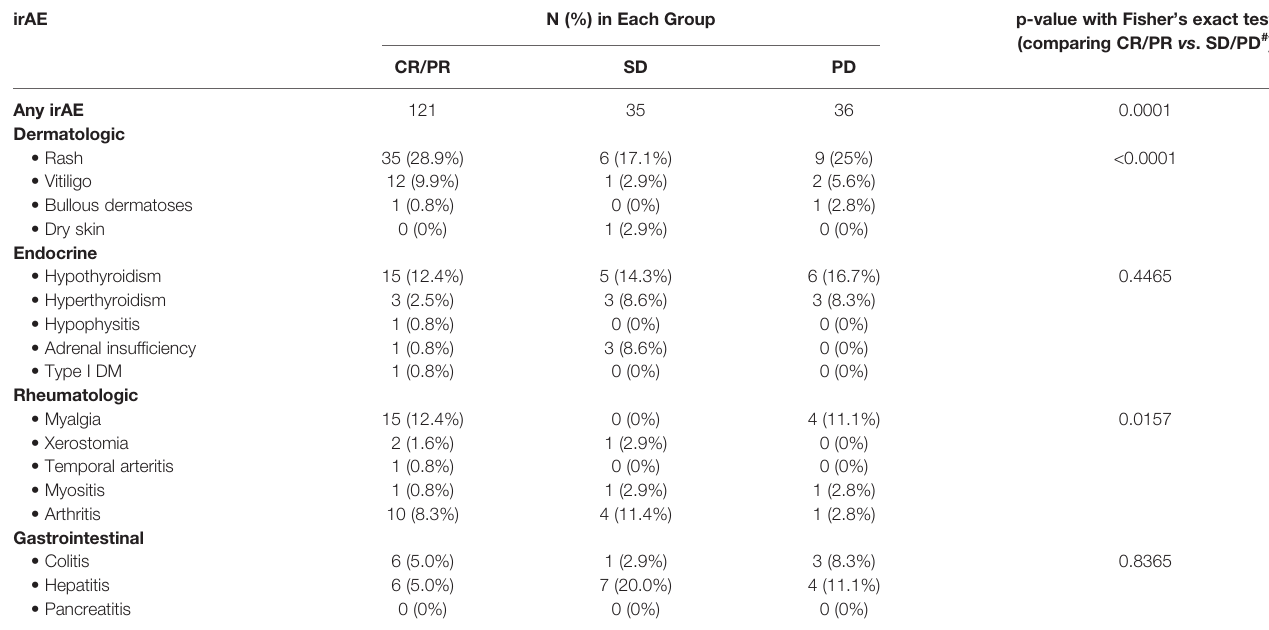
TABLE 2B | Summary of irAE occurrence by response